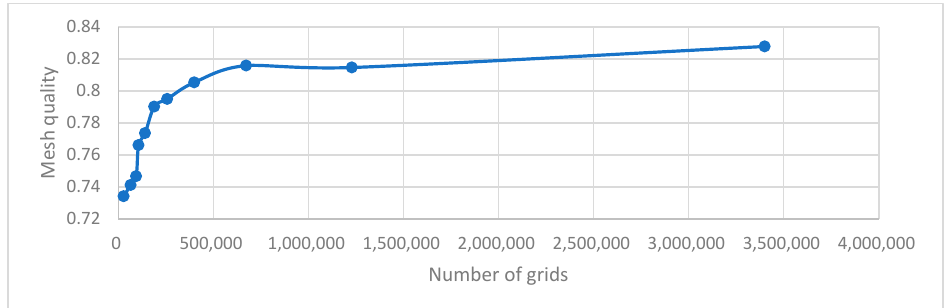
Figure 3. Grid independence test.